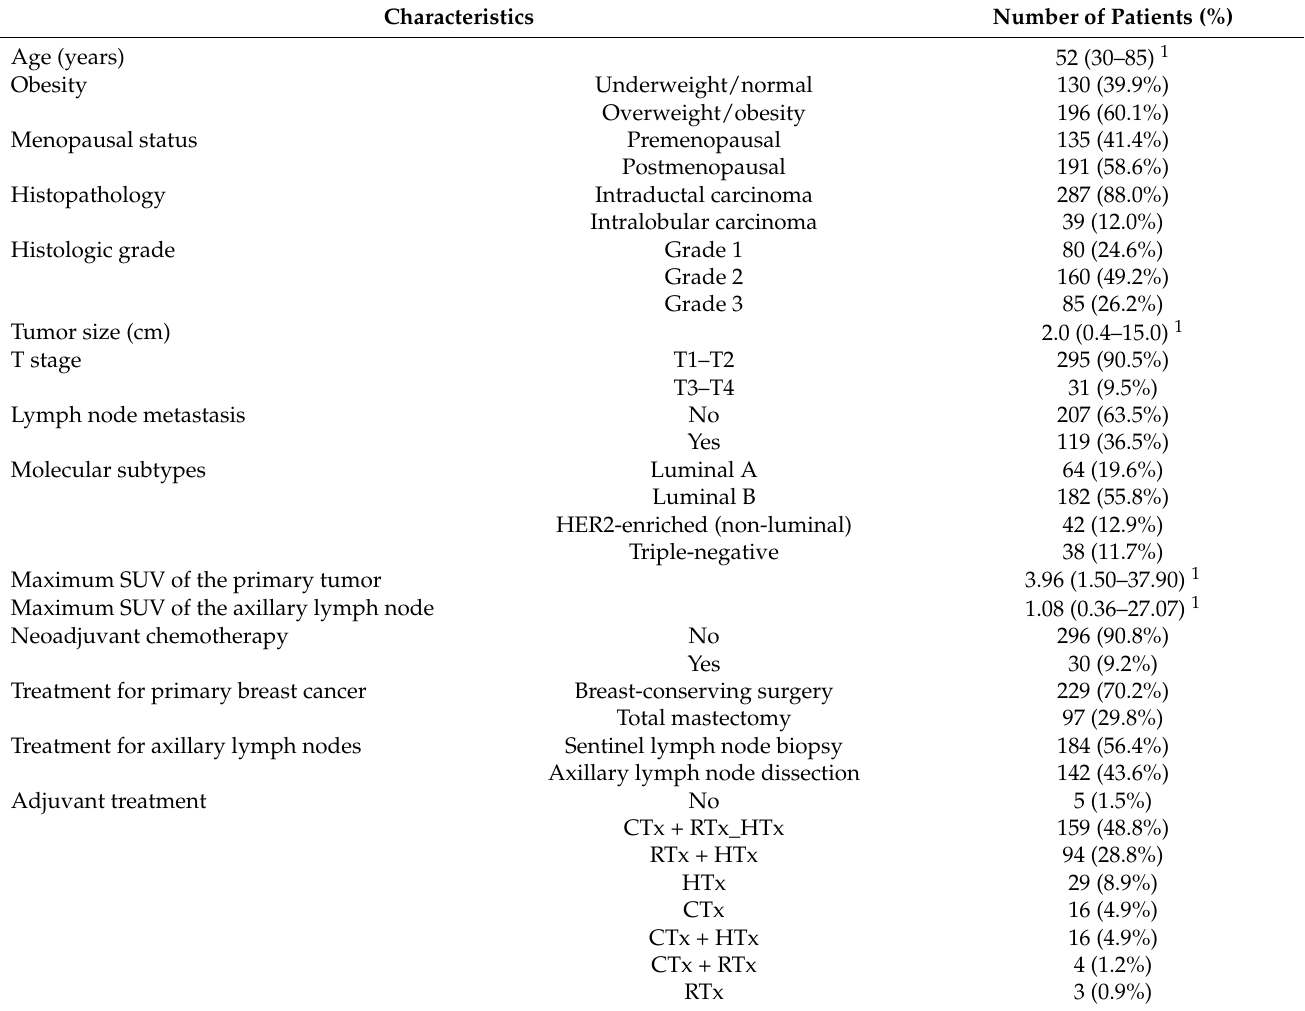
Table 1. Baseline characteristics of the 326